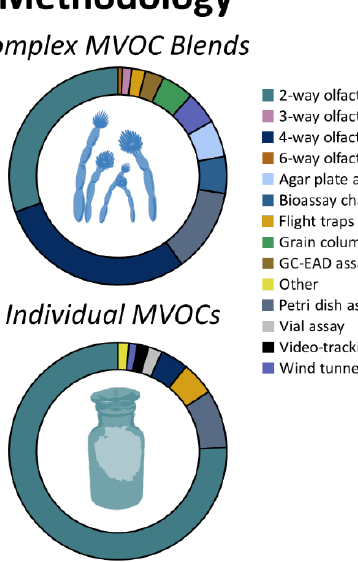
Figure 1. Breakdown of the methodology ( left ) and variables ( right ) used in n = 140 tests documenting the behavioral response by stored-product arthropods to complex blends of microbial cues ( top ) and the n = 243 tests of individual MVOCs in the primary literature from 43 studies ( bottom ). Table 1. Summary of the percent documented occurrences in the primary literature of attraction (+), repellency ( − ), or no statistical difference from included controls ( ) by each of the following (cid:35) stored-product arthropod species among complex blends of microbial